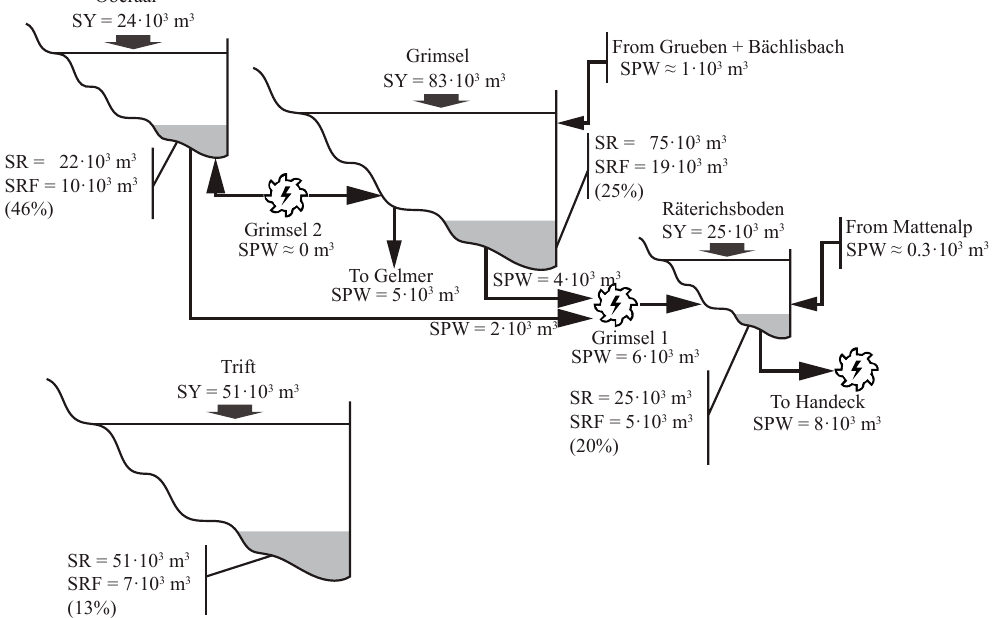
Figure 7. Annual sediment balance for the hydropower cascade formed by the reservoirs Oberaar, Grimsel, and Räterichsboden, and for Trift.